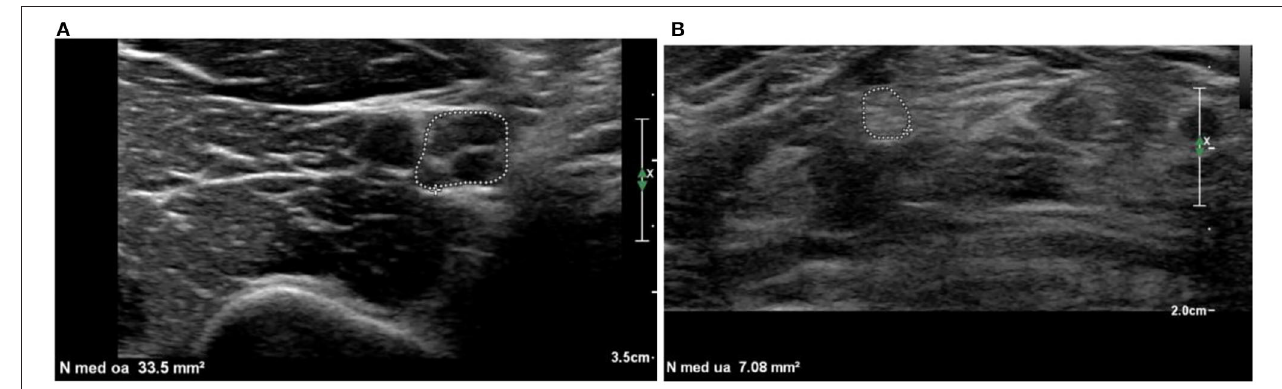
FIGURE 2 | Examples of a hypoechoic (A) and hyperechoic (B) nerve. (A) Median nerve at the upper arm is enlarged (CSA = 33.5 mm 2 ) and shows enlarged hypoechoic fascicles (fraction of black = 85%). (B) Median nerve at the forearm with CSA in normal range, hyperechoic (fraction of black = 9%), fascicles are